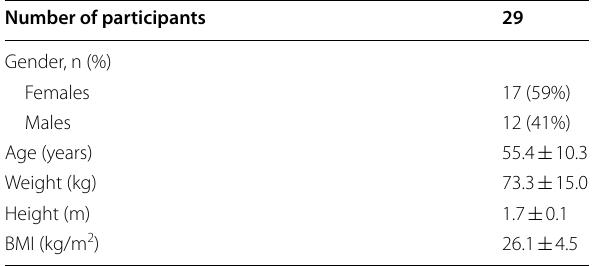
included in the final